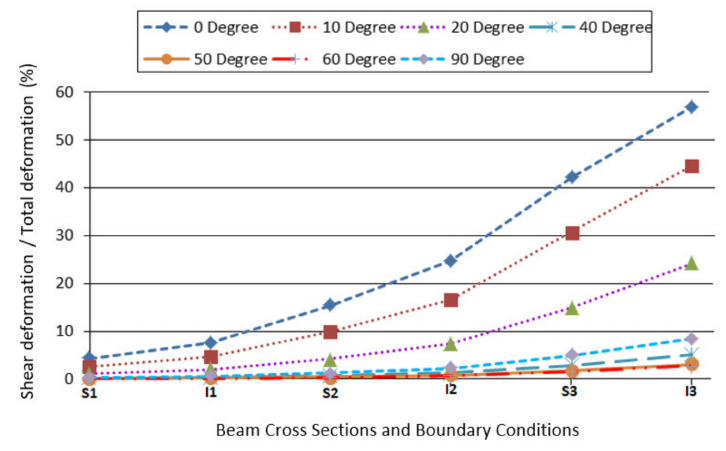
Figure 8. Ratio of shear deformation to total